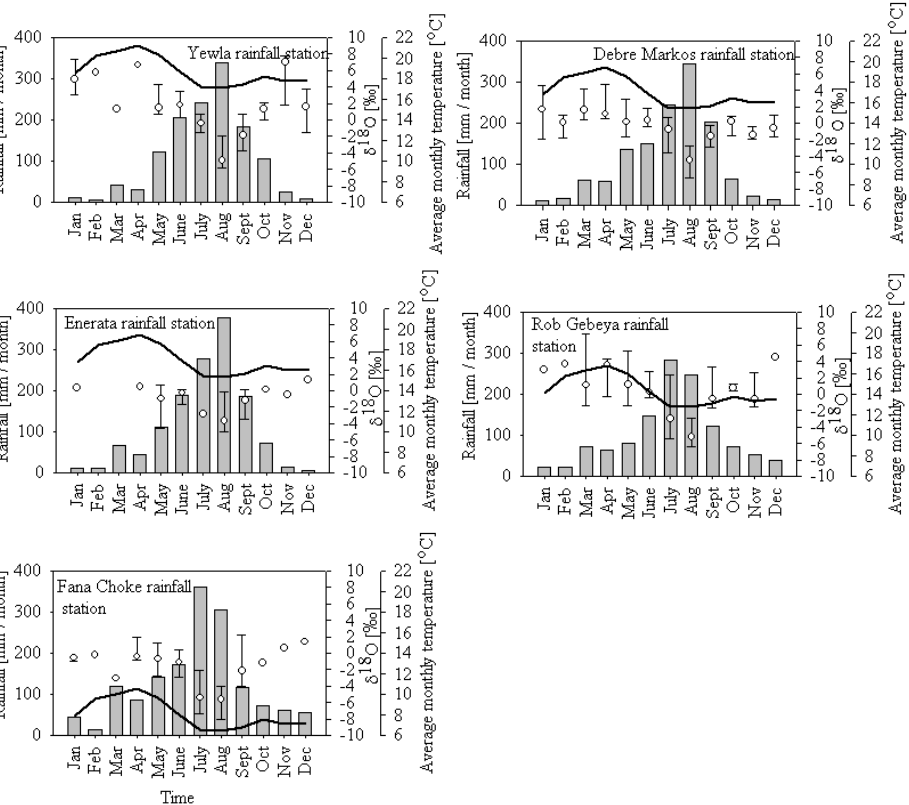
Figure 4. Spatial and intra-annual variations of average monthly precipitation, temperature and isotopic composition of δ 18 O in precipitation. The error bar of the isotopic measurements stand for the standard deviation. Missing error bars for some months are due to limited isotope samples. The grey bar, black solid line and open circle with error bar are the precipitation, temperature and isotopic composition, respectively. For the isotopic composition, the open circle and the lower and upper error bars indicate the median and the 25th and 75th percentiles for the raw (non-weighted) precipitation isotope sample data, respectively.